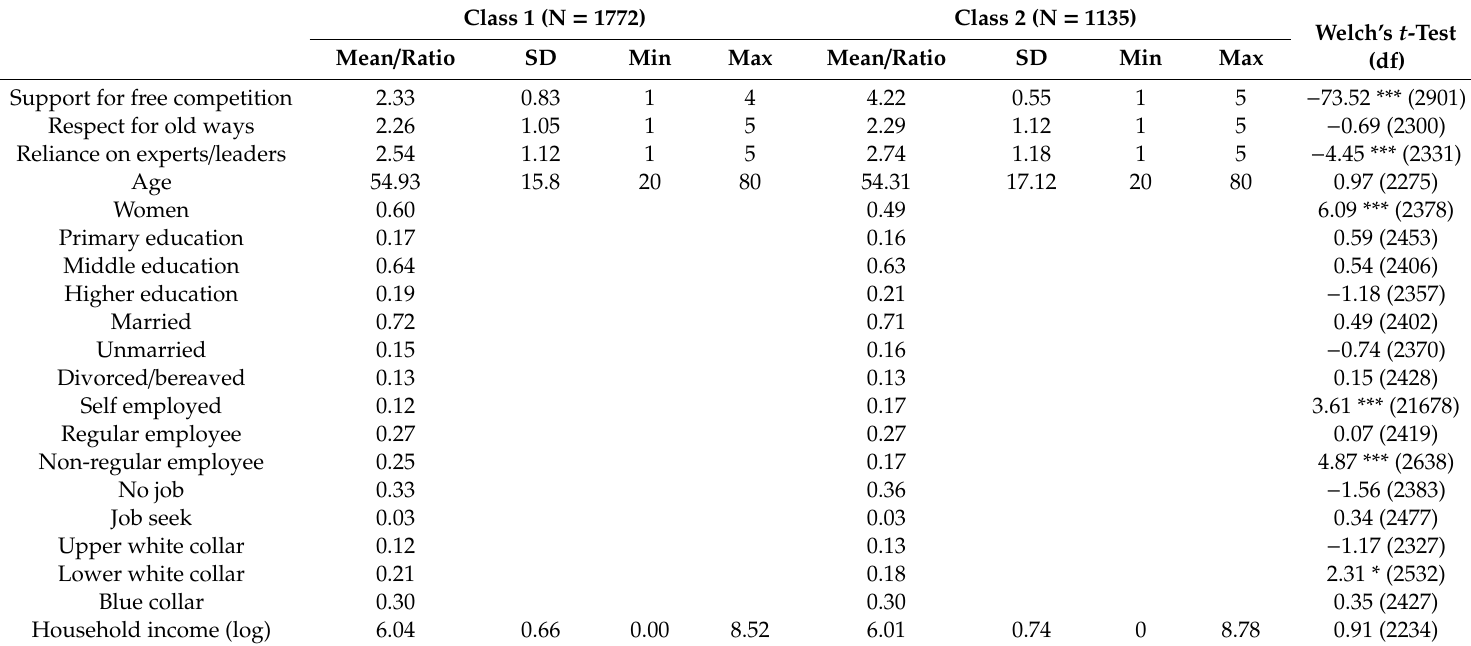
Table 3. Descriptive statistics of supporters of redistribution (Class 1 and Class